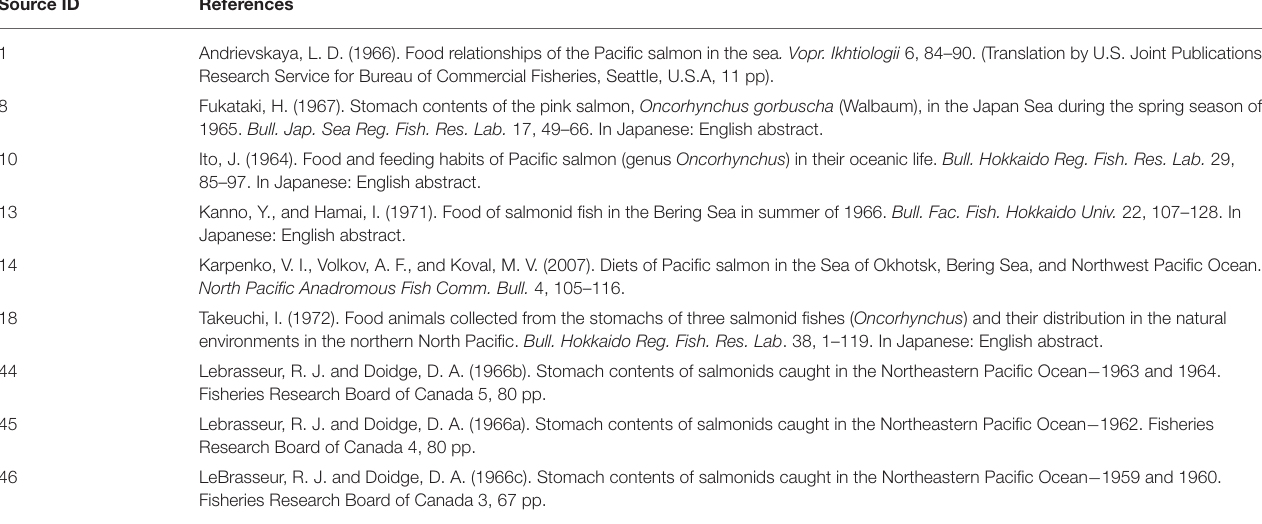
TABLE 2 | The sources from the North Pacific Marine Salmon Diet Database included in the analysis. Source ID